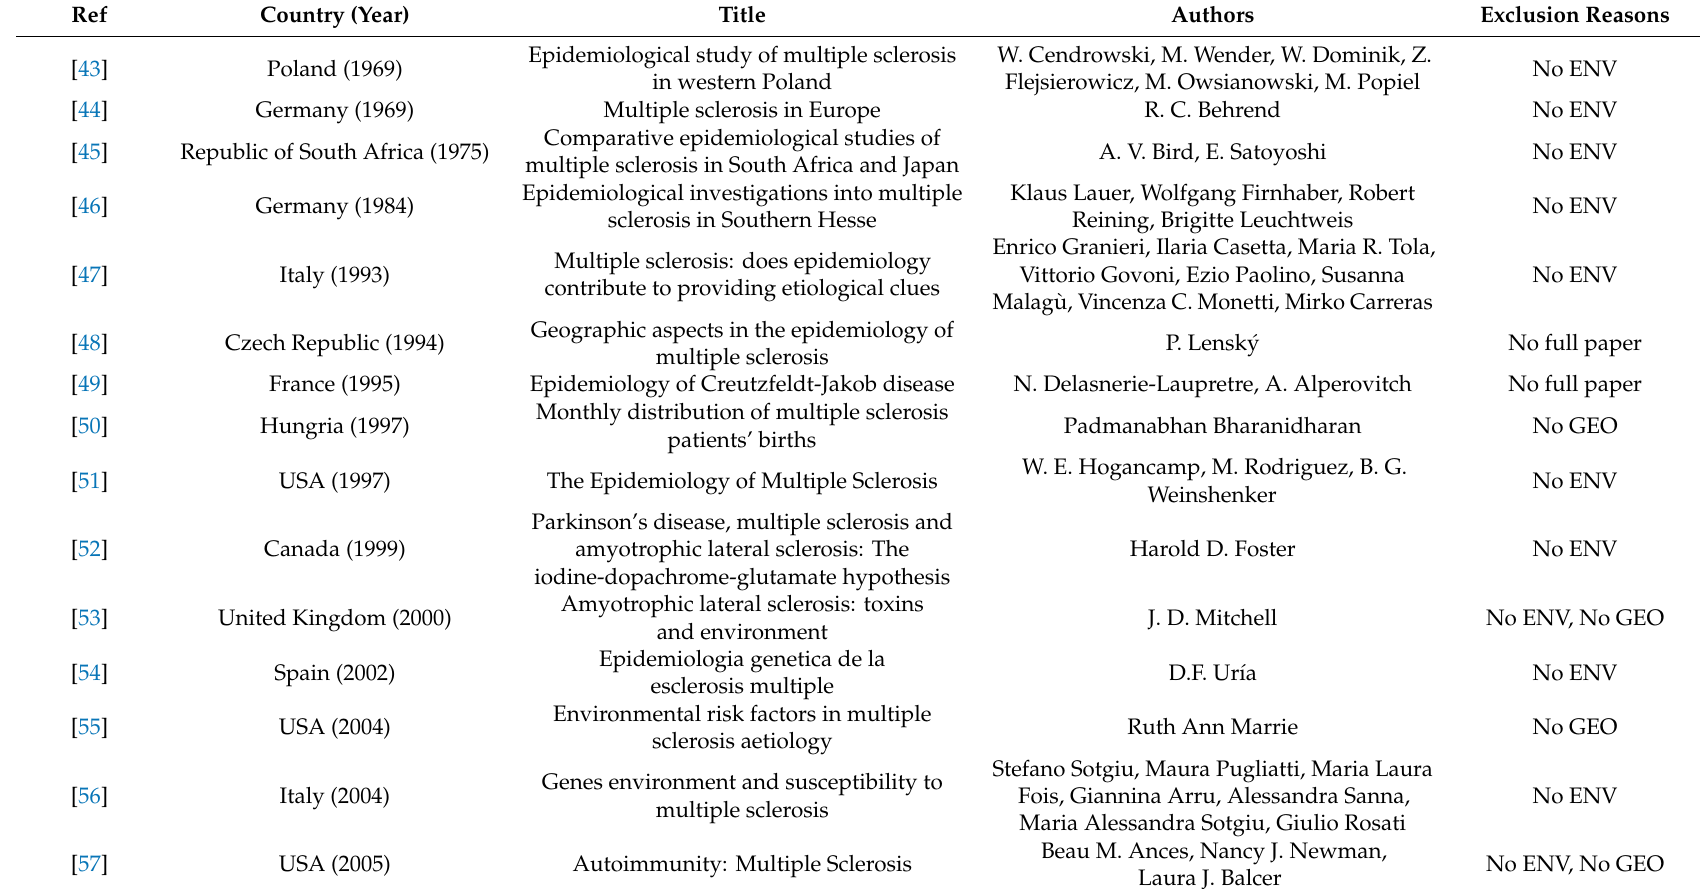
Table A1. List of the 56 excluded